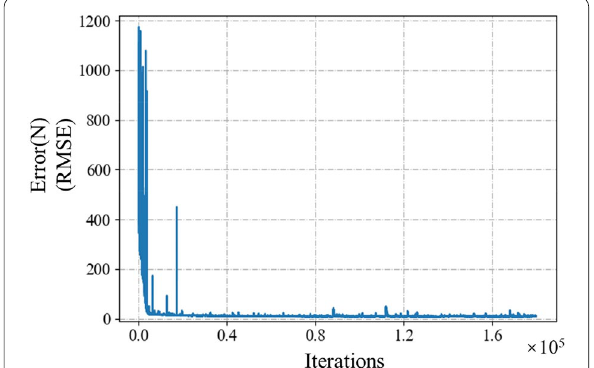
Figure 13 Convergence process with iteration solution with actual monitoring